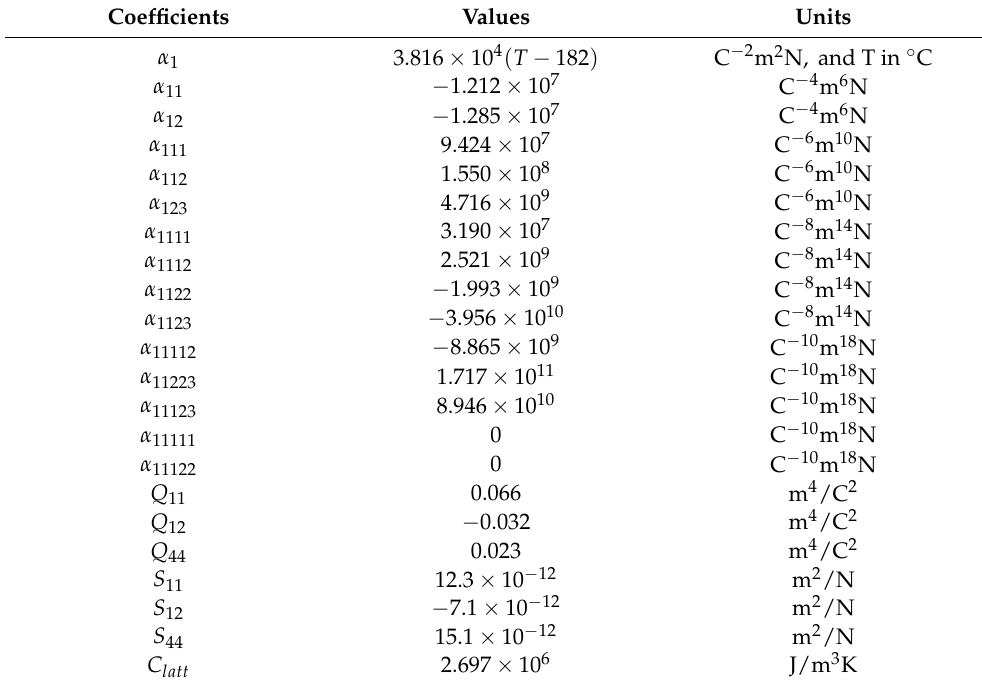
Table 1. The material parameters used in the calculations